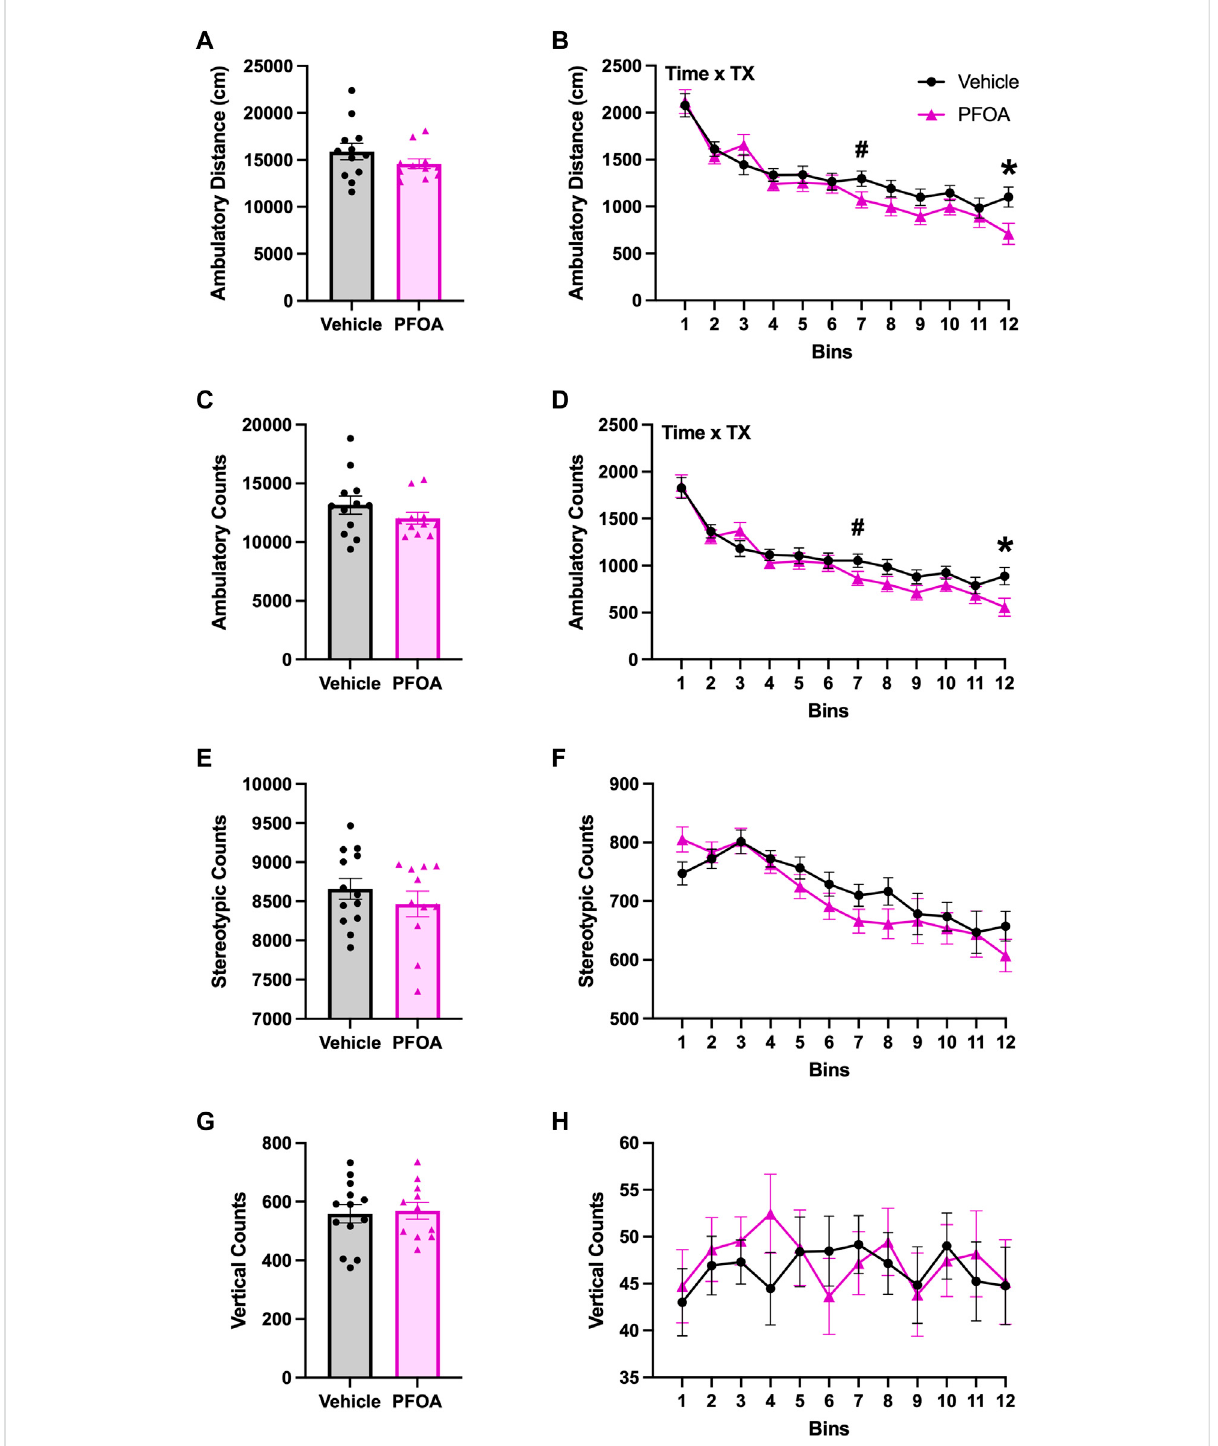
FIGURE 6 Spontaneous Open Field Locomotor. One day after weaning of the pups spontaneous open- fi eld locomotor activity was assessedin the dams. PFOAdamshadnooverallwholesessiondifferencesinambulatorydistance (A) ,ambulatorycounts (C) ,stereotypiccounts (E) ,orverticalcounts (G) . Ambulatory distance (B) and ambulatory counts (D) had signi fi cant time bytreatmentinteractions presentwith reductions inambulation.No time by treatmentinteractionswereobservedinstereotypiccounts (F) ,orverticalcounts (H) .Datashownasmean±standarderrorofthemean, n =11/ PFOA and n = 12-13/vehicle. Data analyzed with either two-sided student ’ s t-test or repeated measures ANOVAs followed by two-sided student ’ s t-test. Asterisks means p ≤ 0.05 and number sign means p ≤